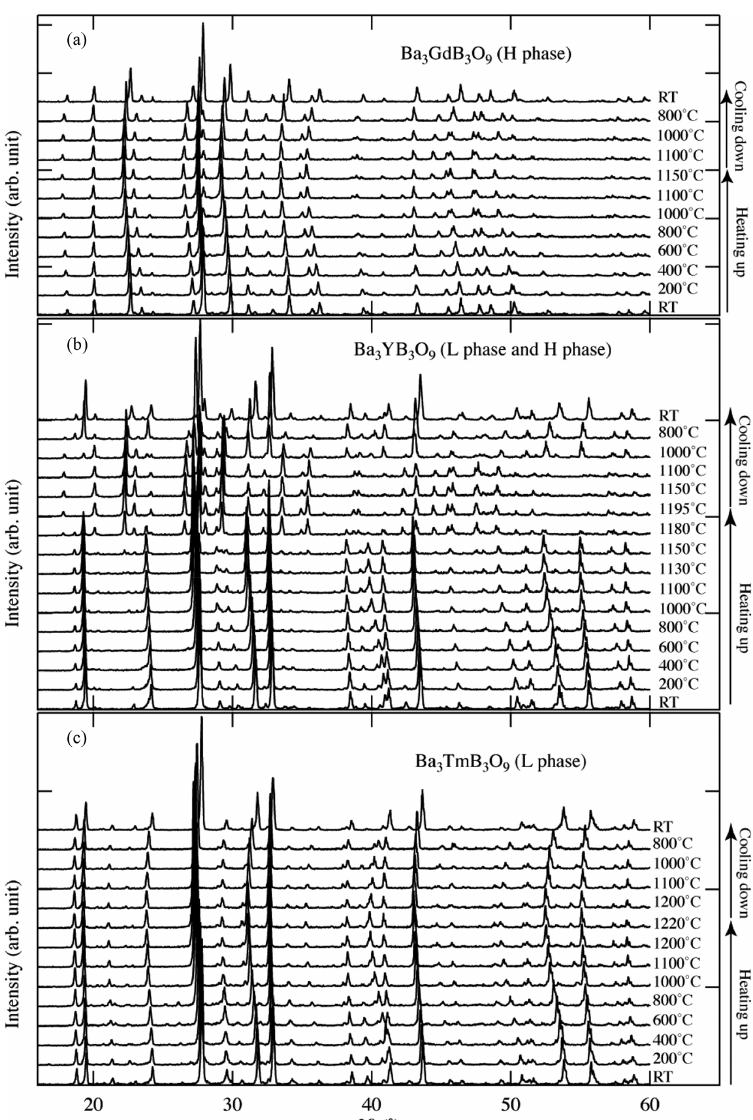
Figure 3: Representative patterns from the three types of typical XRD diffractions for Ba 3 R B 3 O 9 ; (a) H phase only, R = Gd; (b) H and L phase, R = Y; and (c) L phase only R = Tm. The numbers in the graph show the measurement temperature and RT indicates room